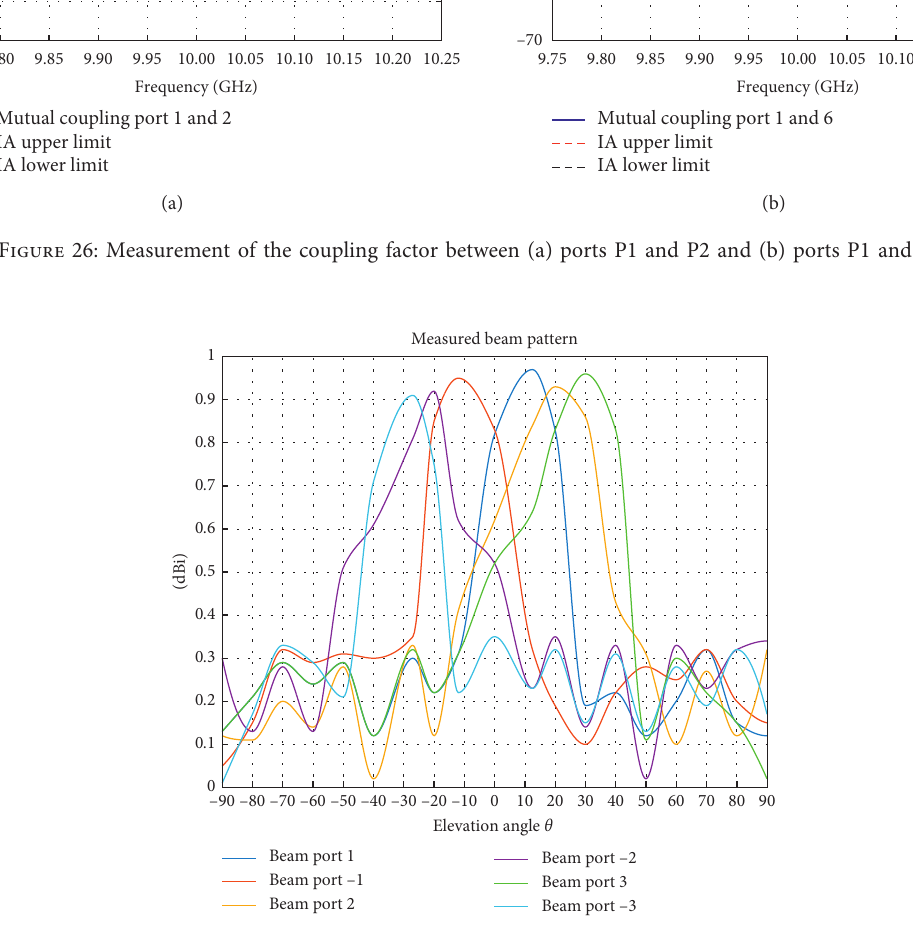
Figure 27: Measured beam patterns at the six beam ports.